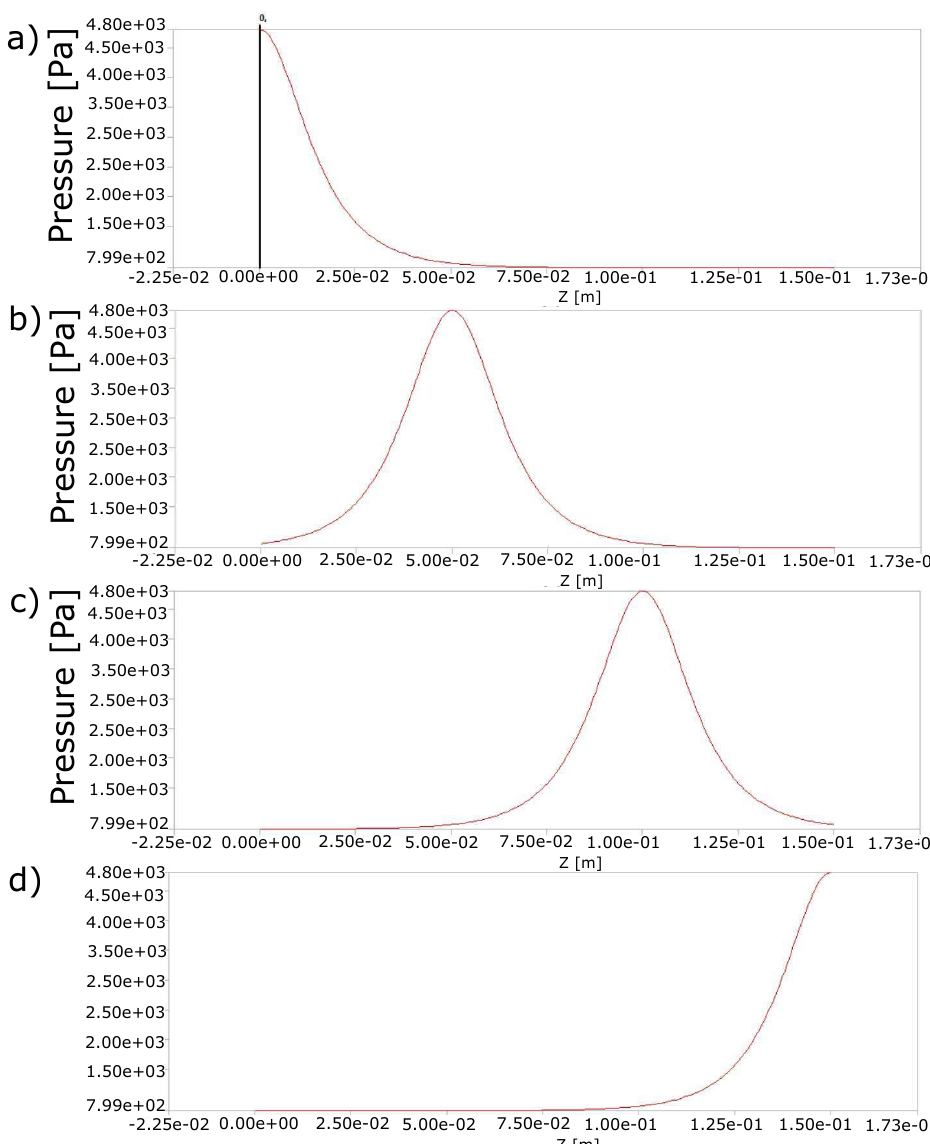
Figure 9. Travel of the peristaltic wave on the z-axis over time: ( a ) 0 s, ( b ) 10 s, ( c ) 20 s and ( d ) 30 s, which were repeated for another 30 s after passing the second wave. Changes in pressure as a consequence of muscle contractions contributed to the transport of the fecal mass and with it the biomarker particles that were released in the process of cell